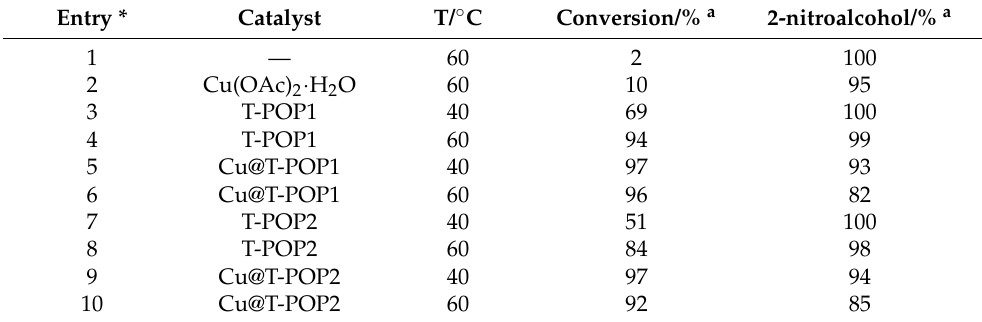
Table 6. Influence of catalyst type on the Henry reaction between 4-nitrobenzaldehyde and